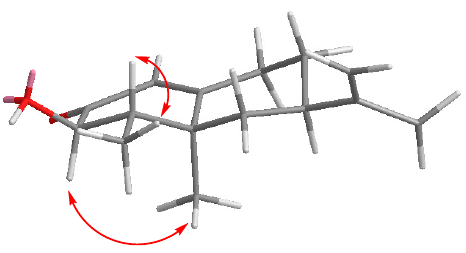
Figure 3. Selected NOESY correlations observed for compound 14 .